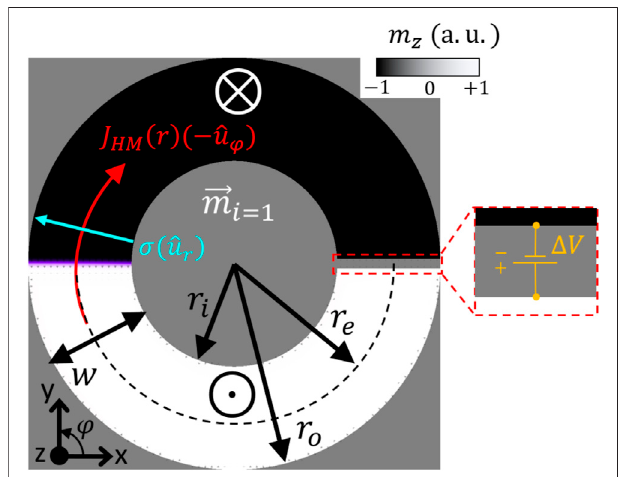
FIGURE1| Schemeshowingtherelaxedstatesofspinsinsub-lattice i (cid:2) 1, in the positive z -direction (white domain), in the negative z -direction (black domain) and in the plane of the strip for an “ Up to Down ” (UD) domain wall (purple)accordingtothecurrentdirection, foranexemplarycurvedstrip. The direction of the applied electric current (red arrow) in the Heavy Metal beneath the magnetic strip, generated from a potential difference Δ V (see inset), is shown as well as the geometrical parameters of the